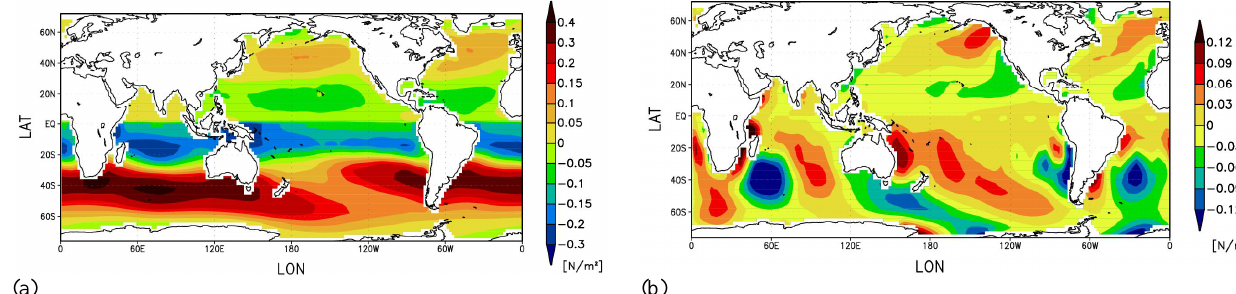
Fig. 8. (a) 800yr mean climatology of τ x (N m − 2 ) for the coupled model run. (b) The same as in (a) , but for τ y (N m − 2 ) (c)